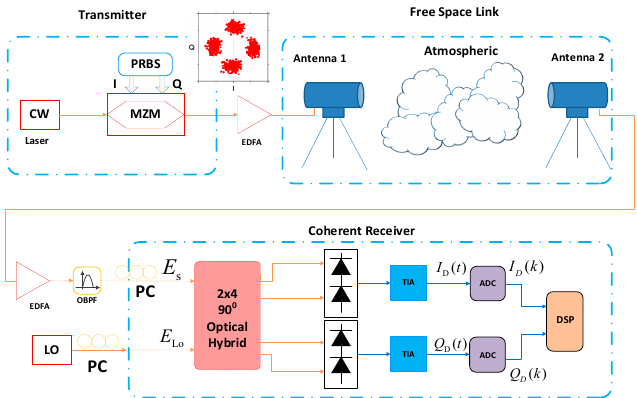
Figure 1. Schematic of a free-space optical communication (FSO) system. CW: continuous-wave laser, MZM: Mach–Zehnder modulator, EDFA: Erbium-doped fiber amplifier, OBPF: optical bandpass filter, PC: polarization controller, TIA: transimpedance amplifier, ADC: analog-to-digital converter, DSP: digital signal processing.